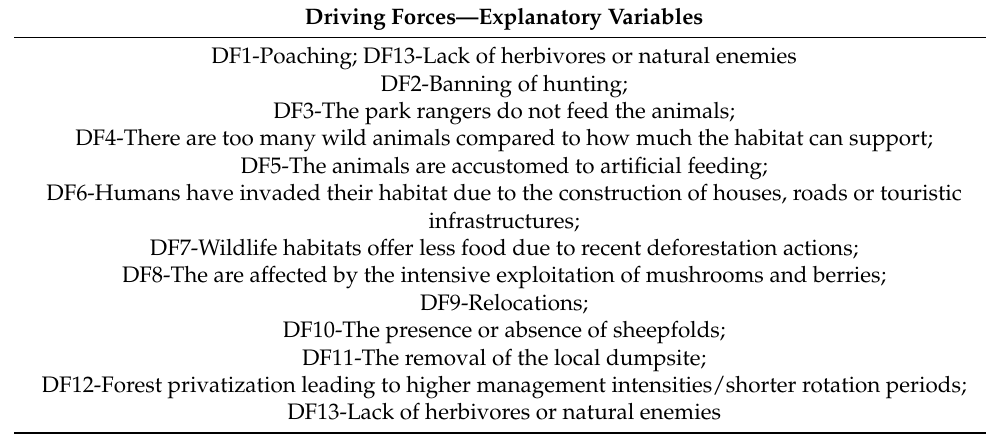
Table A4. The explanatory variables (driving forces) and response variables (presence and absence of species within a specific time period) used for the CCA